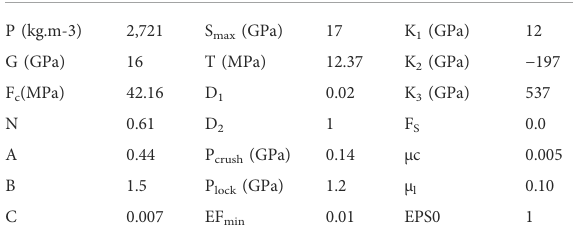
TABLE 3 Parameters of the HJC model for